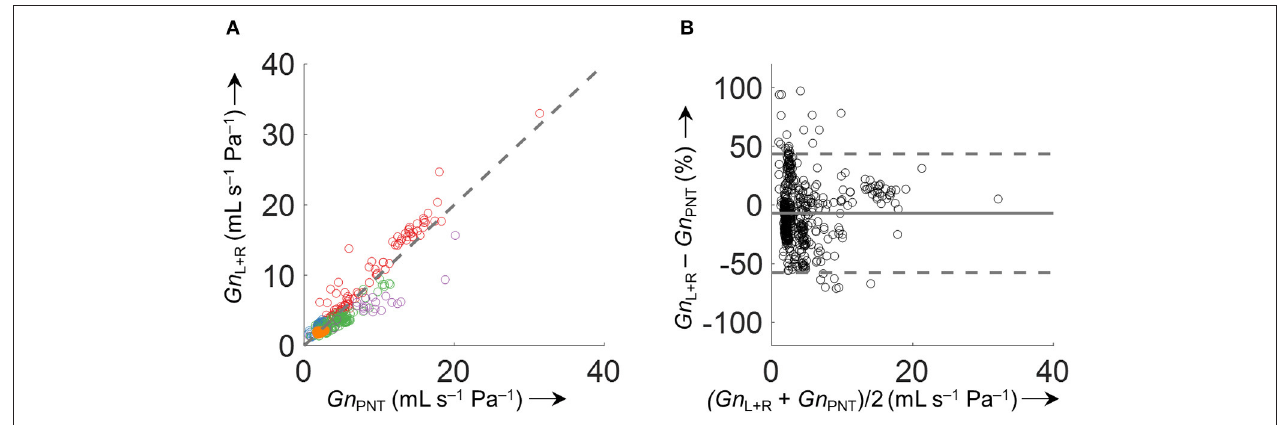
P Epi,max Fn L ( P Epi,min ) + R P Epi,max P Epi,min . (A) Identity plot of derived total nasal conductance (cid:0) (cid:1) − −